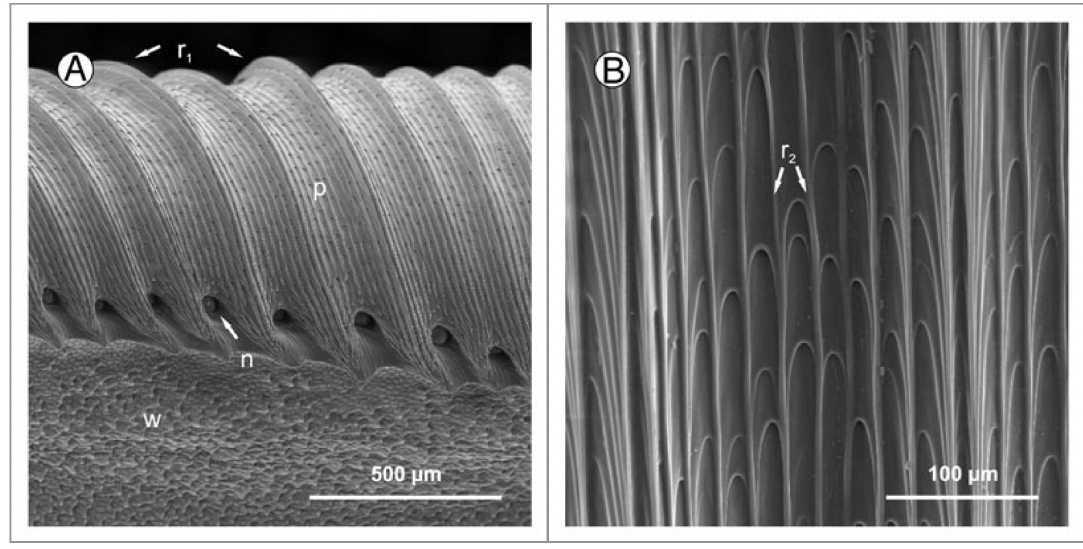
( a ) Peristome surface (p) of Nepenthes alata , structured by first- (r second-order (r ) radial ridges. In between tooth-like projections at inner edge of the 2 peristome, pores of large extrafloral nectaries (n) can be seen. Below the peristome is wax-covered inner wall surface (w). ( b ) Second-order ridges (r rows of overlapping epidermal cells. From Bauer and Federle